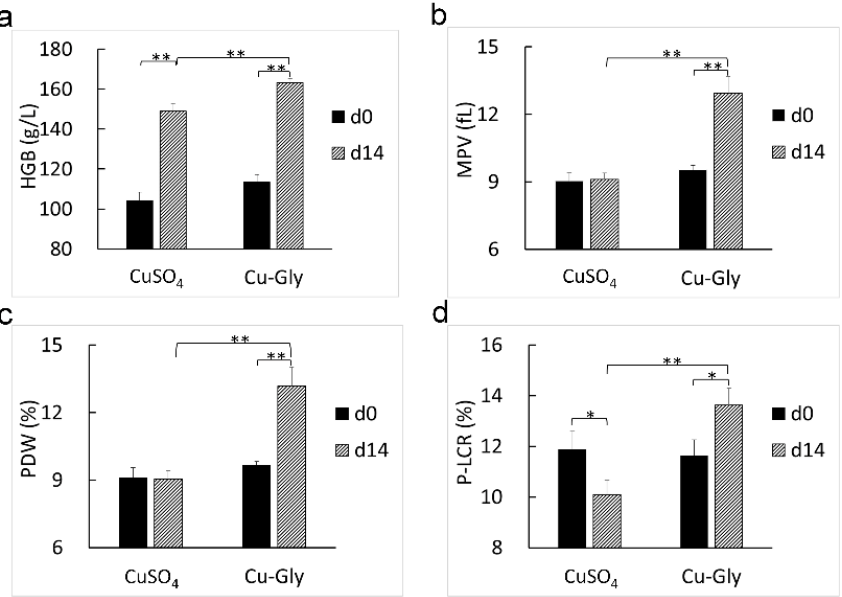
Figure 1. Effects of Cu sources on the hematology parameters of pigs. Hematology analysis was performed, and only a significant difference in hematology parameters, including HGB ( a ), MPV ( b ), PDW ( c ), and P-LCR ( d ), was shown. Data present mean values ± standard errors. * represents a significant difference at p < 0.05, and ** represents a significant difference at p < 0.01. n = 6. HGB, hemoglobin; MPV, mean platelet volume; PDW, platelet distribution width; P–LCR, platelet–larger cell ratio.